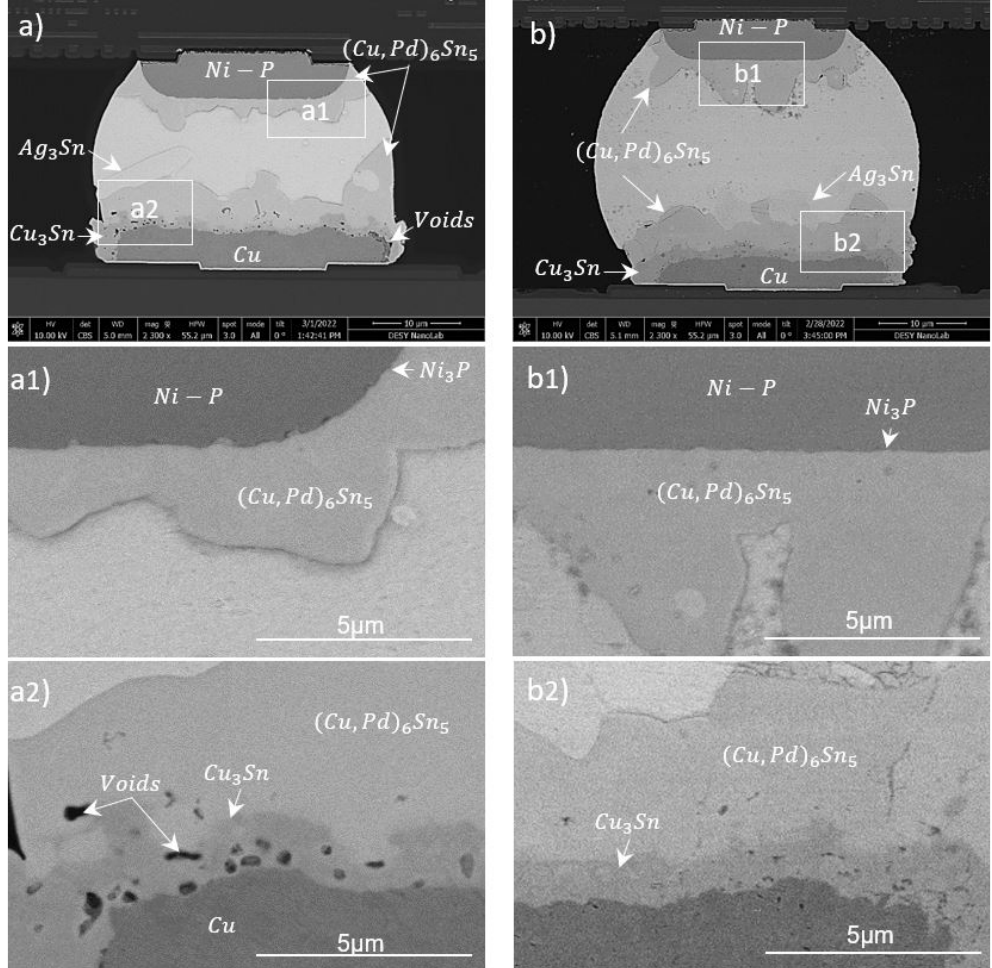
Figure 14. HTS tests of Cu30/100-ENEPIG28 modules bonded using 30µm spheres ( a ) and 40µm spheres ( b ). Magnified views of upper and lower UBM interfaces for both samples are shown as ( a1 ) and ( b1 ); and ( a2 ) and ( b2 ),